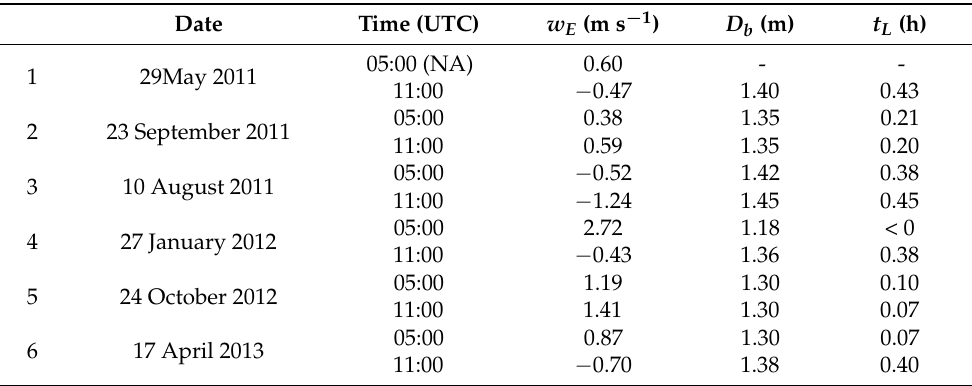
Table 3. Fitting radiosonde D b to ECMWF vertical